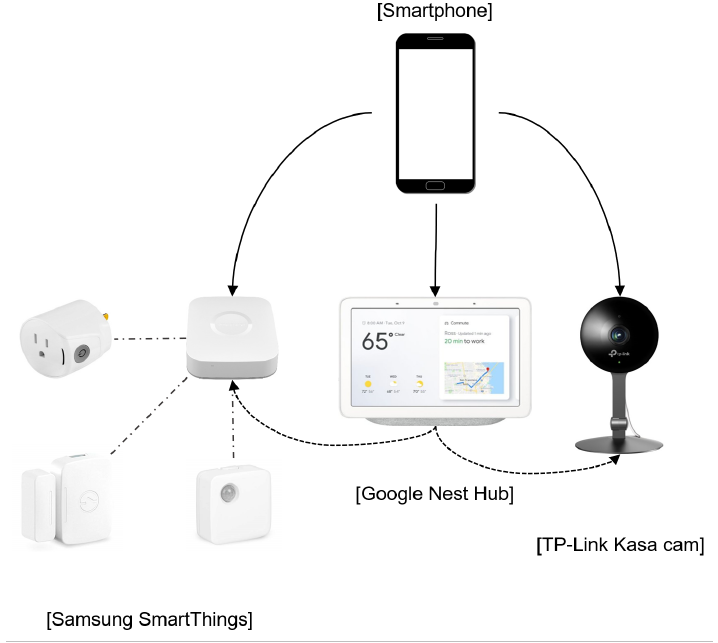
Figure 2. Target smart home